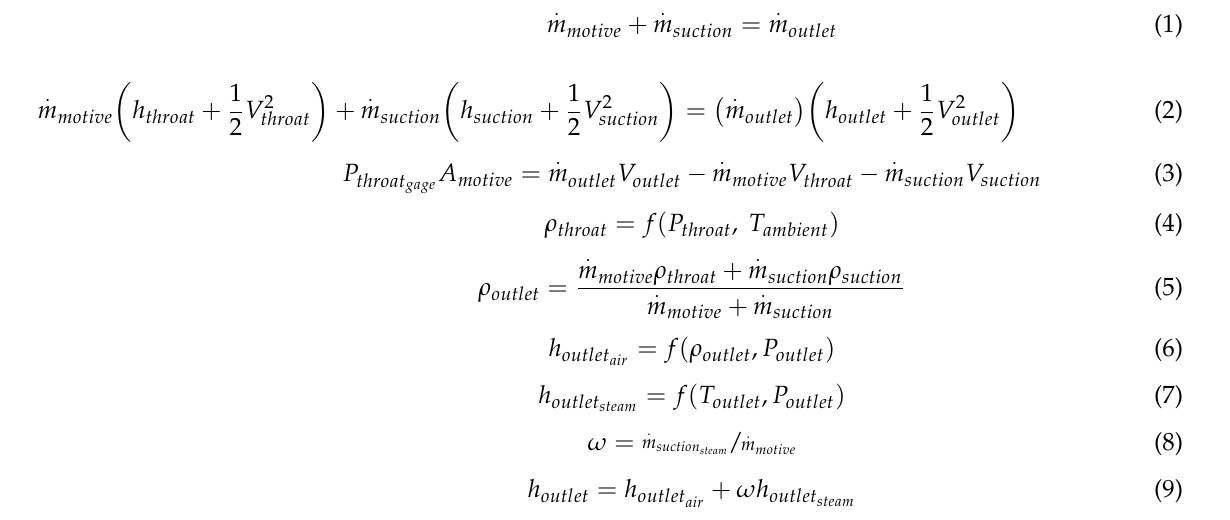
Table 3. Geometries were chosen to provide a range of values for each of the selected geometrical parameters: motive diameter, throat diameter, suction diameter, and mixing length. Each parameter was varied to provide at least four different values. These